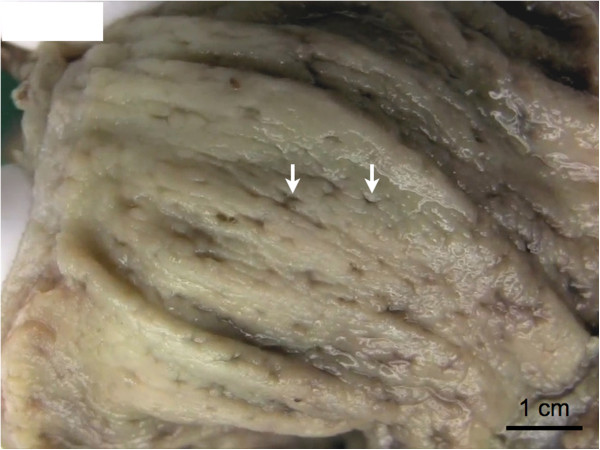
Macroscopic aspect of the colonic mucosa. Multiple small ulcerations of a few millimeter diameter were seen dispersed over the entire mucosa of the colon (arrows).